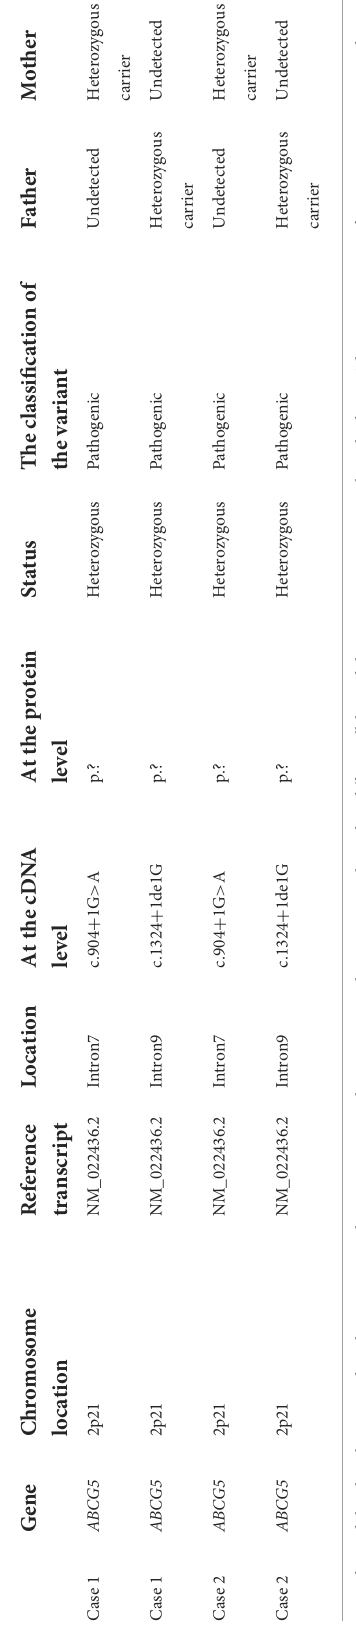
TABLE 2 Blood lipid levels before and after lipid-lowering